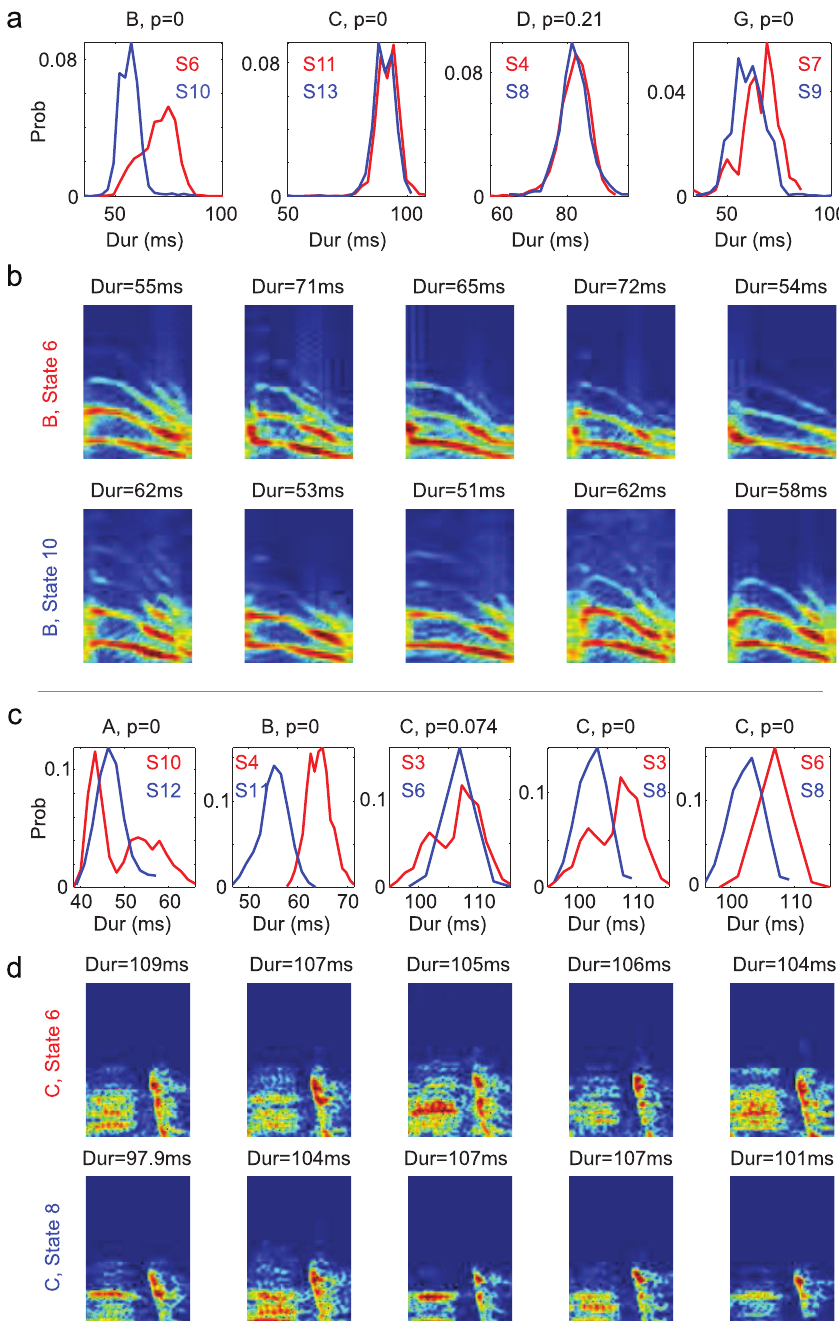
Figure 11. Evidence of many-to-one mapping from the states to the syllables. Panels a and b are for Bird 1, and c and d for Bird 2. a and c . Syllable durations of the same syllable types associated with different states in the POMM shown in Figure 7a and in Figure 9a, respectively. In each graph, red and blue curves are from different states. The state labels are shown with corresponding colors. The p -values on top test the significance that the differences of the means of the two distributions are non-zero. The syllable types are shown on top. b and d . Spectrograms of randomly selected examples of syllables of the same type associated with different states in the POMM. Durations of the syllables are shown on top. Frequency range of the spectrograms is from 1–10kHz. syllable A associated with state 12 in the POMM (Figure 12a), number distributions associated with single states in the which is replaced with two serial states both with adaptive self- POMM. transition probabilities in the POMMA. The systematic Taken together, the results on syllable durations provide some variations of syllable durations on the positions in repetition evidence for the validity of the many-to-one mapping from the supports the idea of using multiple states to model repeat states to the syllables.